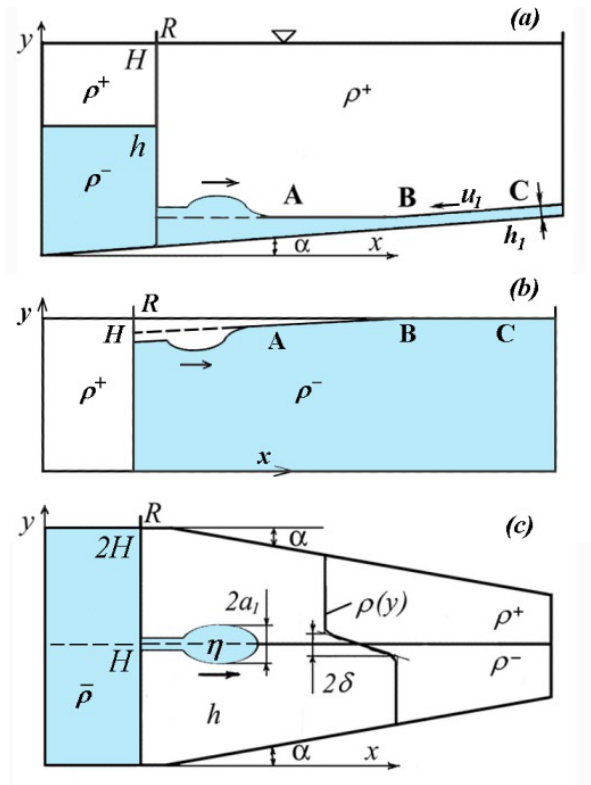
Fig. 1. A sketch of the lock problem in two layer fluid (side view). Internal waves are generated by the removal of slice gates R : (a) run up of the bottom internal waves; h 1 is the thickness of a thin layer of dense fluid flowing along the slope; (b) short intrusion along the subsurface layer of light fluid of variable thickness; (c) solitary waves of the second mode at the interface between symmetric ho- mogeneous layers of different